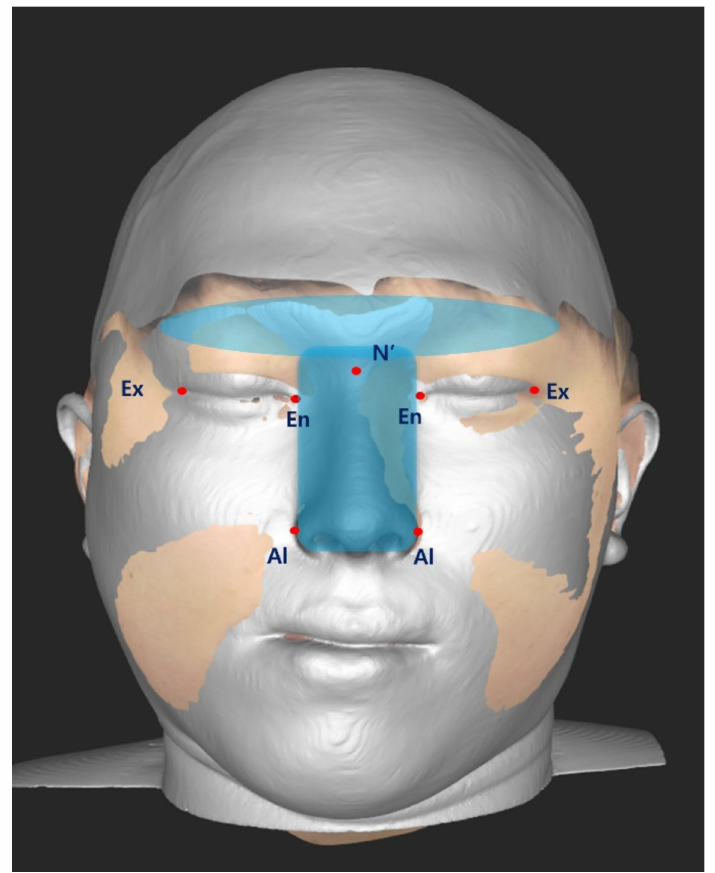
Figure 1. Registration of preoperative (T1) CT and FS images. The references used for superimposition were the forehead and the dorsum of the nose area (blue color), exocanthions, endocanthions, and nasal alas: N’, soft tissue nasion; Ex, exocanthion; En, endocanthion; Al, nasal ala; CT, computed tomography; and FS, facial